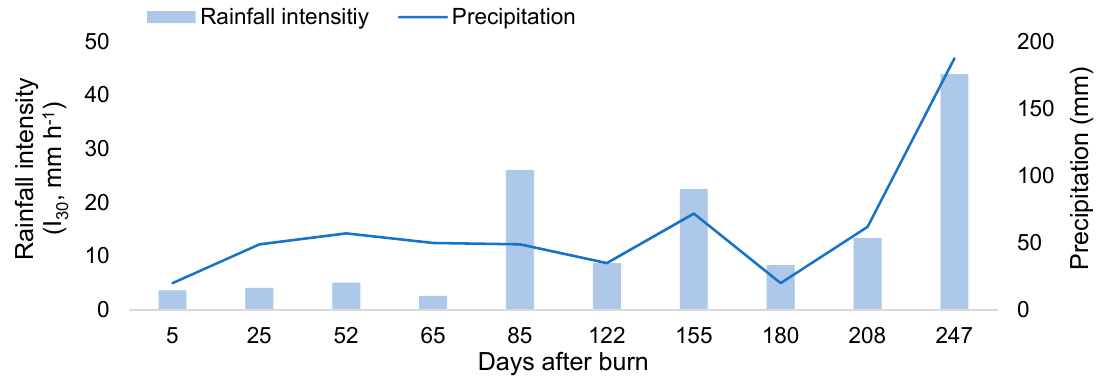
Figure 1. Temporal precipitation (mm) and maximum rainfall intensity (I 30 , mm h − 1 ) in the period between 5 and 247 days after pile burning.